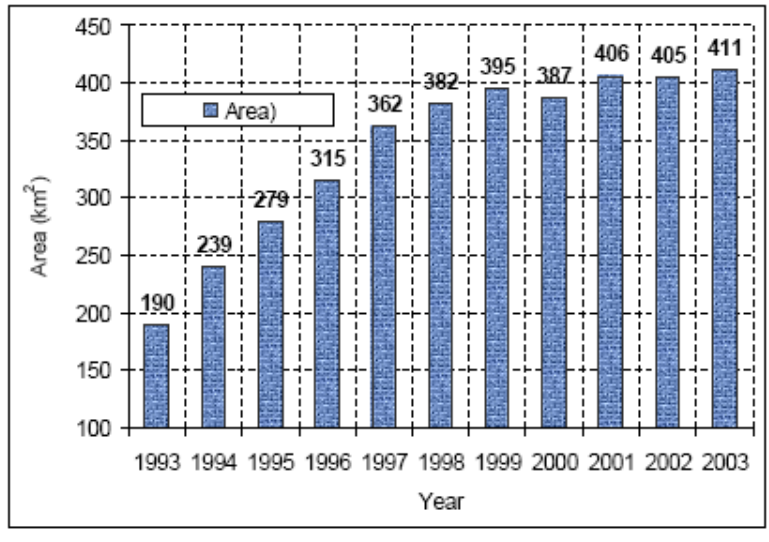
Figure 4. Devils Lake surface area progressions from Landsat